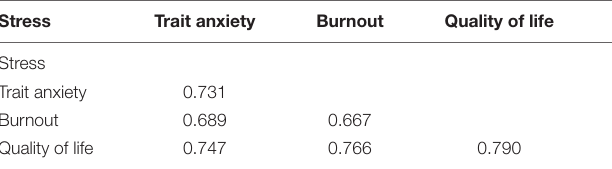
TABLE 2 | Divergence validity results (HTMT